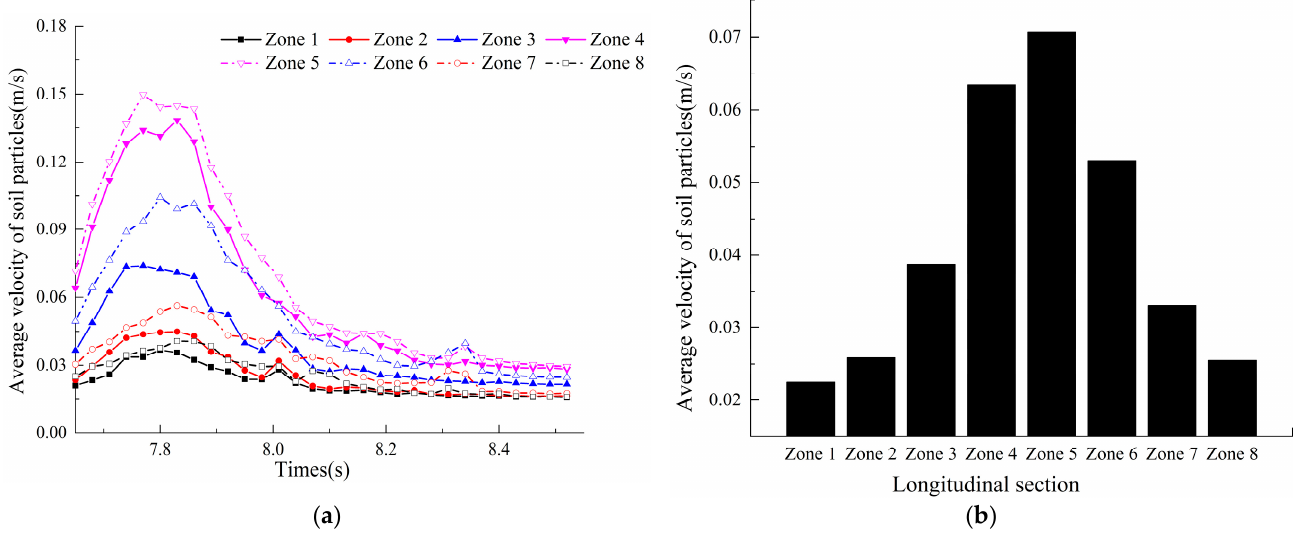
Figure 10. Variation curves of motion in different regions of the longitudinal section. ( a ) Particle motion curve in the longitudinal section; and ( b ) velocity variation in different